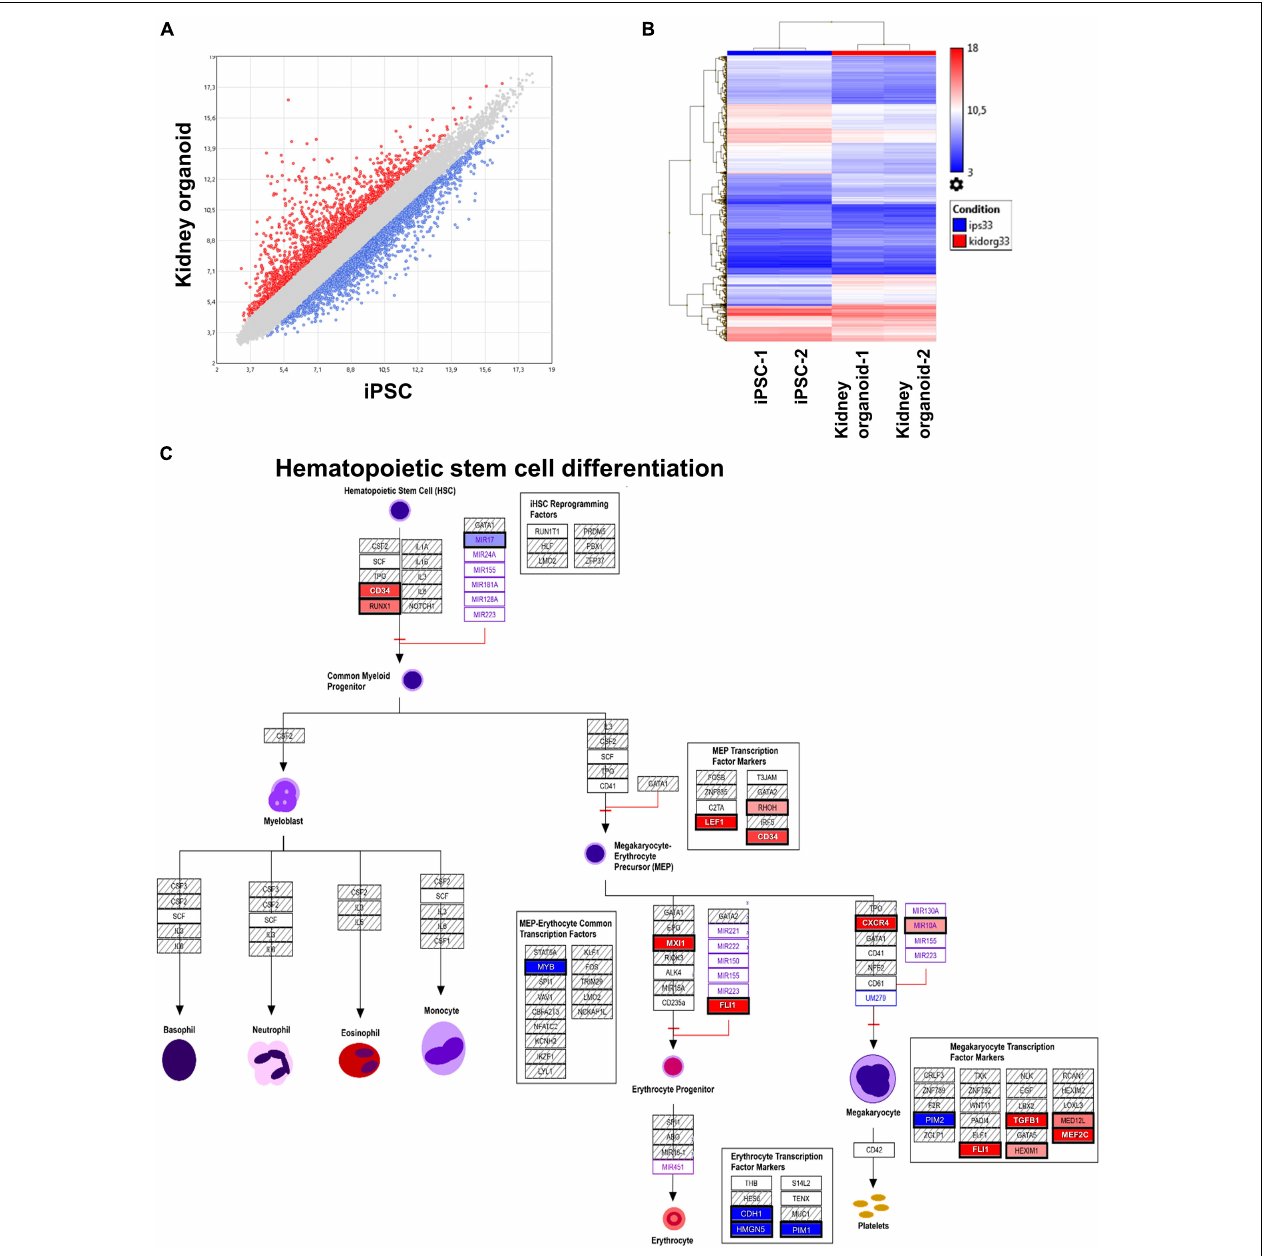
FIGURE 4 | Transcriptional program induced in kidney organoid derived from human induced pluripotent stem cells (iPSCs). (A) Scatterplot of differentially expressed genes found in transcriptome of kidney organoid versus iPSC. (B) Expression heatmap with unsupervised classification performed on differentially expressed genes induced during kidney organoid differentiation from iPSC. (C) Functional enrichment performed on WikiPathway database showing potential implication hematopoietic stem cell function during differentiation of kidney organoid derived from human